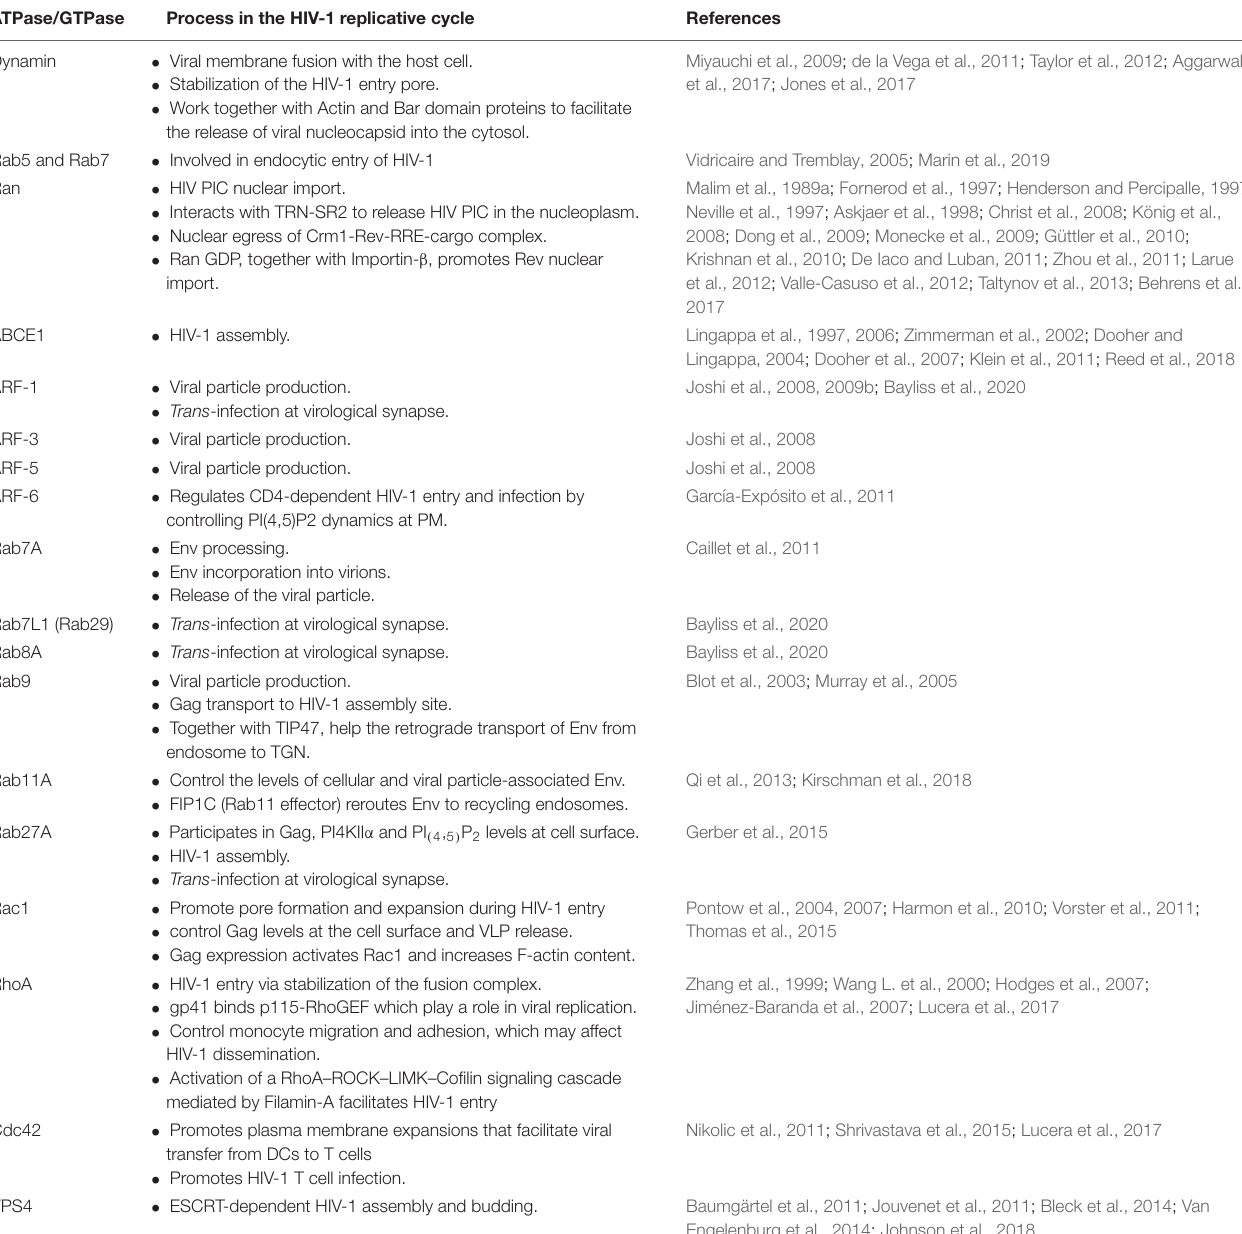
TABLE 1 | ATPases and GTPases co-opted by HIV-1 during its replication cycle are presented in the order that they appear in the text. ATPase/GTPase Process in the HIV-1 replicative